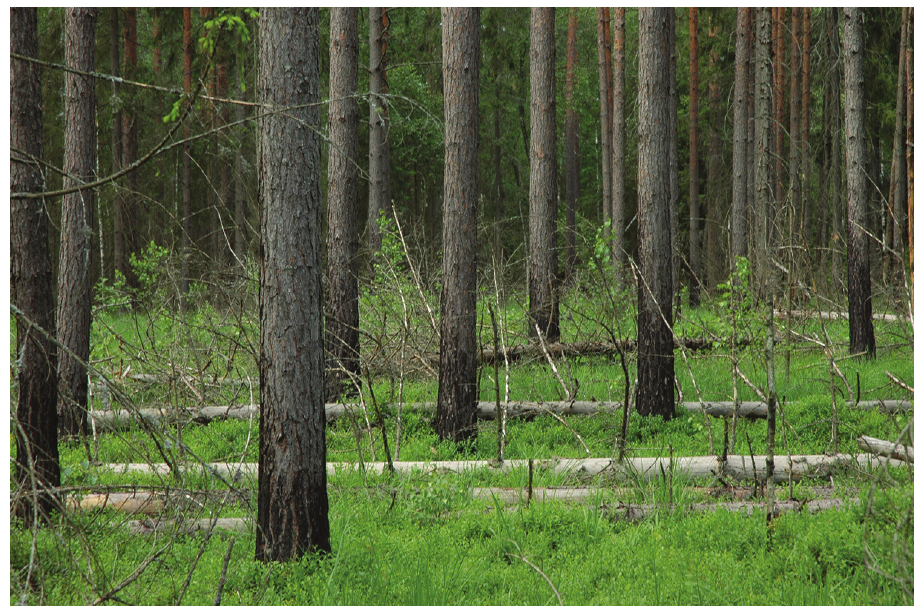
Figure 2. Scots pines burned by fire – host trees of Stephanopachys linearis (photo by J.M. Gutowski, 2017).